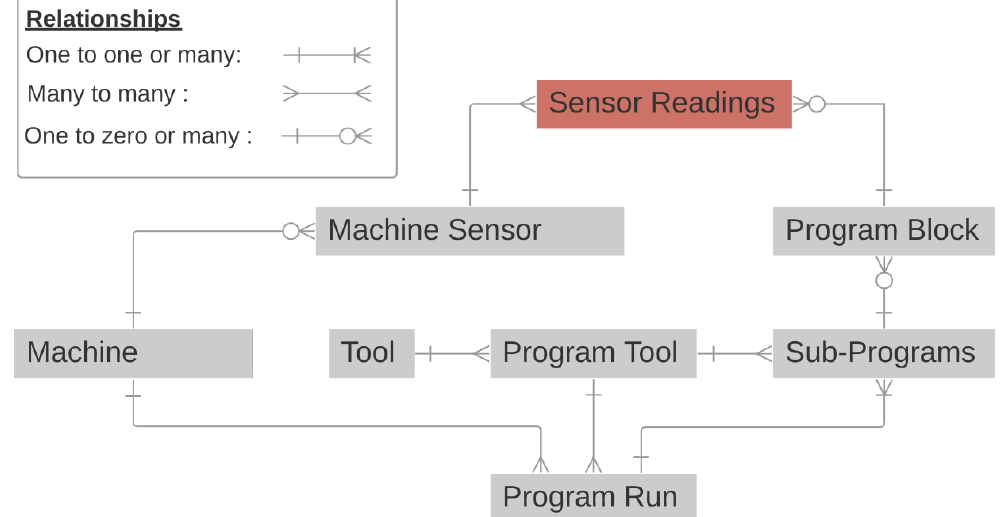
Figure 1. Diagram of data relationship at our industrial